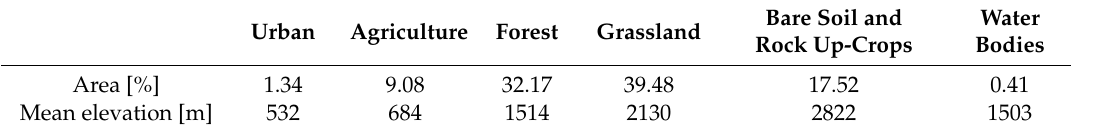
Table 1. Catchment area covered by each land use class [%] and corresponding mean elevation. Urban Agriculture Forest Grassland